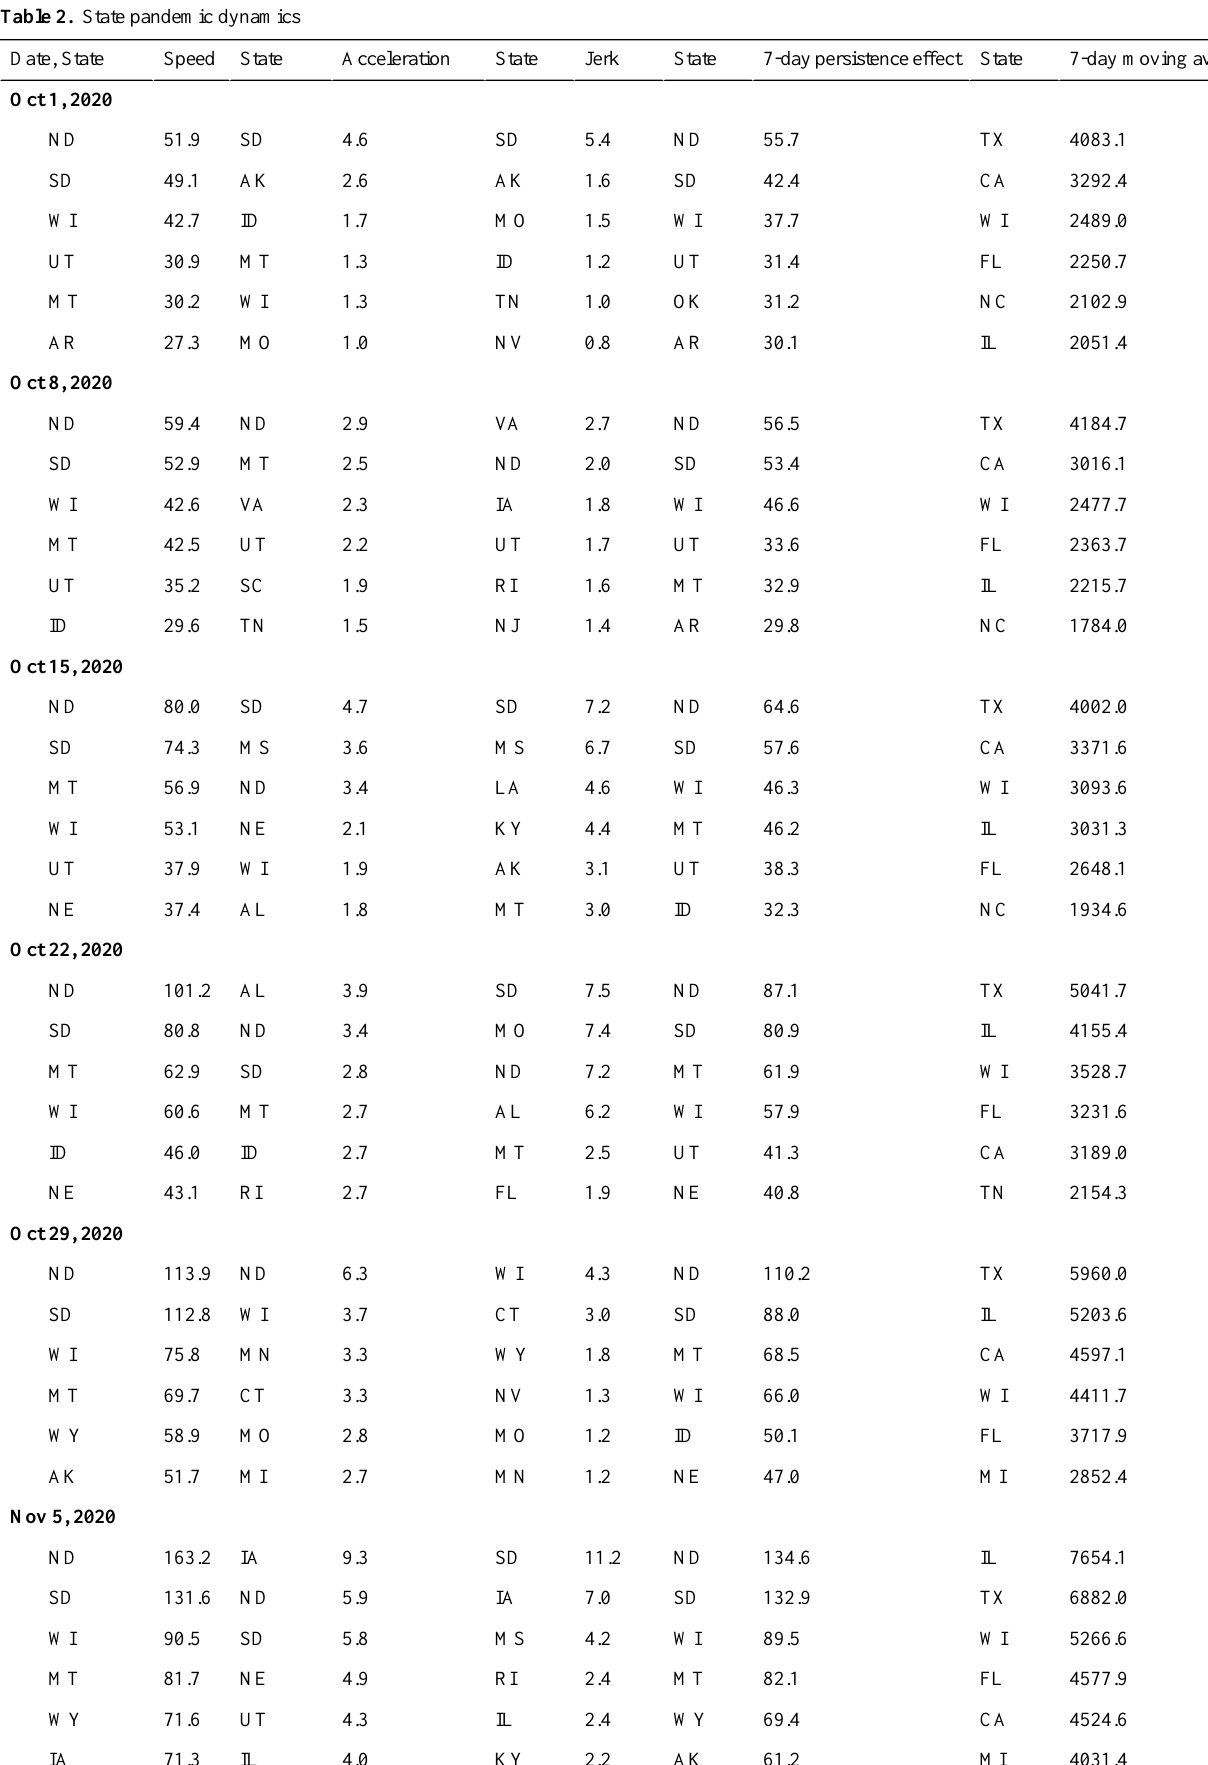
Table 2. State pandemic